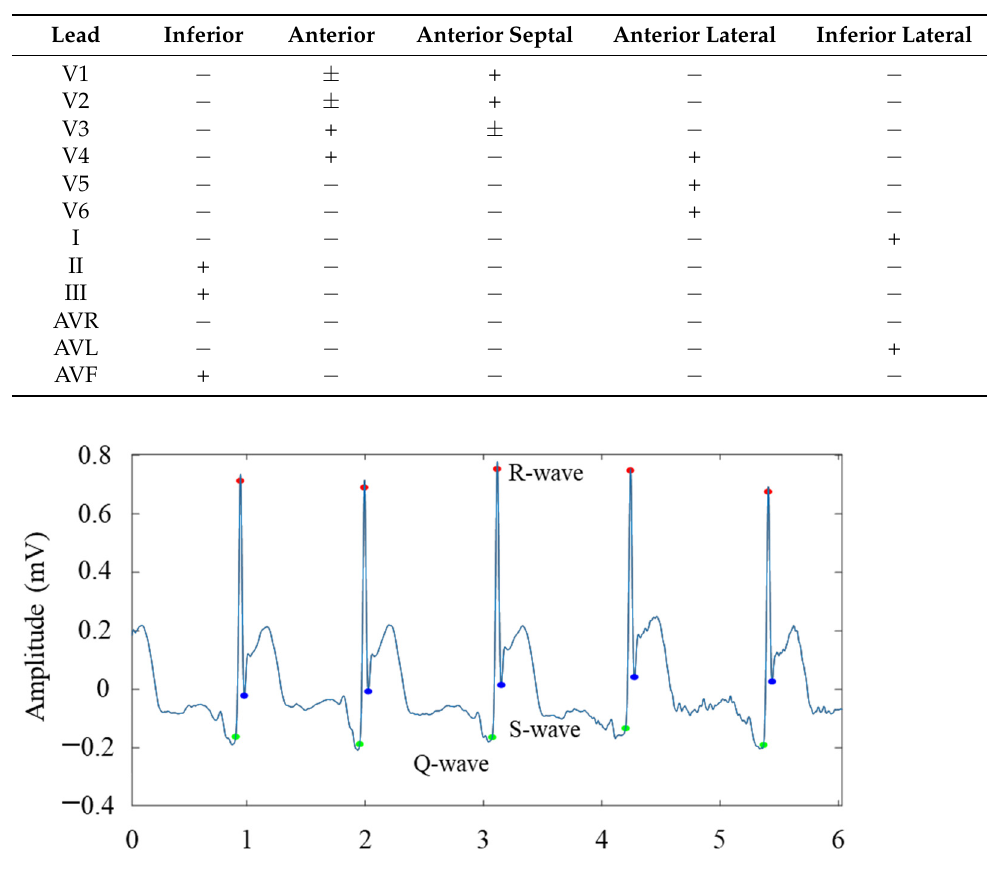
Table 3. Description of feature extraction.